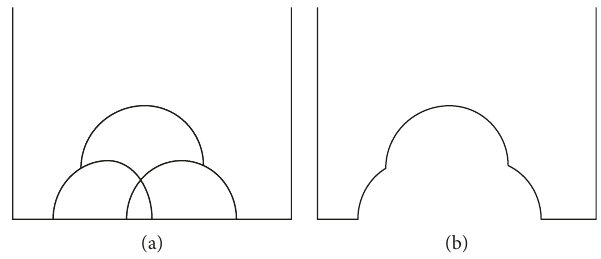
Figure 6: Material removal strategy by simulation in workpiece discharge. (a) Intersectional volume removal. (b) Material removal by simulation.